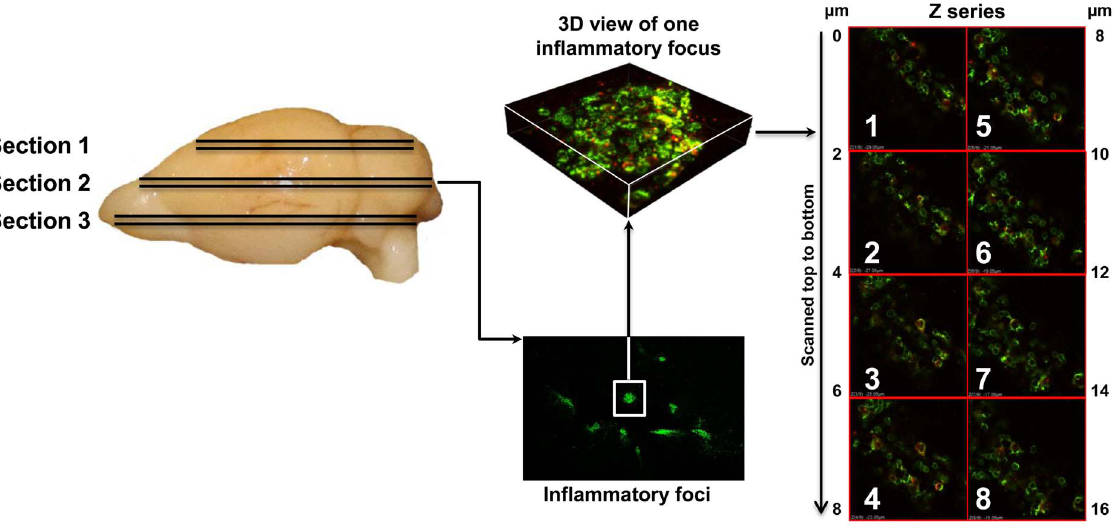
Figure 3. Quantitative analysis of PLP-specific CD4 T cells detected by insitu staining with PLP 139–151 dextramers in EAEmice. Three paired cerebral sections, each 200 m m thick, were made from brains obtained from EAEmice using vibratome by cutting the sections from the dorsal to the ventral surface with 1.5 mm intervals between pairs. One section from each pair was stained with either PLP 139–151 or TMEV 70–86 (control) dextramers together with anti-CD4. After fixing and mounting, the sections were examined by LSCM (60X), and each inflammatory focus was subjected to a set of ‘Z’ serial images (15 to 25) taken sequentially. In total, 10 to 15 sets of such ‘Z’ serial images representing as many inflammatory foci were acquired from each section. In all the images, cells positive for both PLP 139–151 dextramers and CD4 or CD4 alone were counted using ‘ImageJ’ software. Finally, the cells counted in all the ‘Z’ serial images obtained from all the inflammatory foci were added to obtain the total number per section.